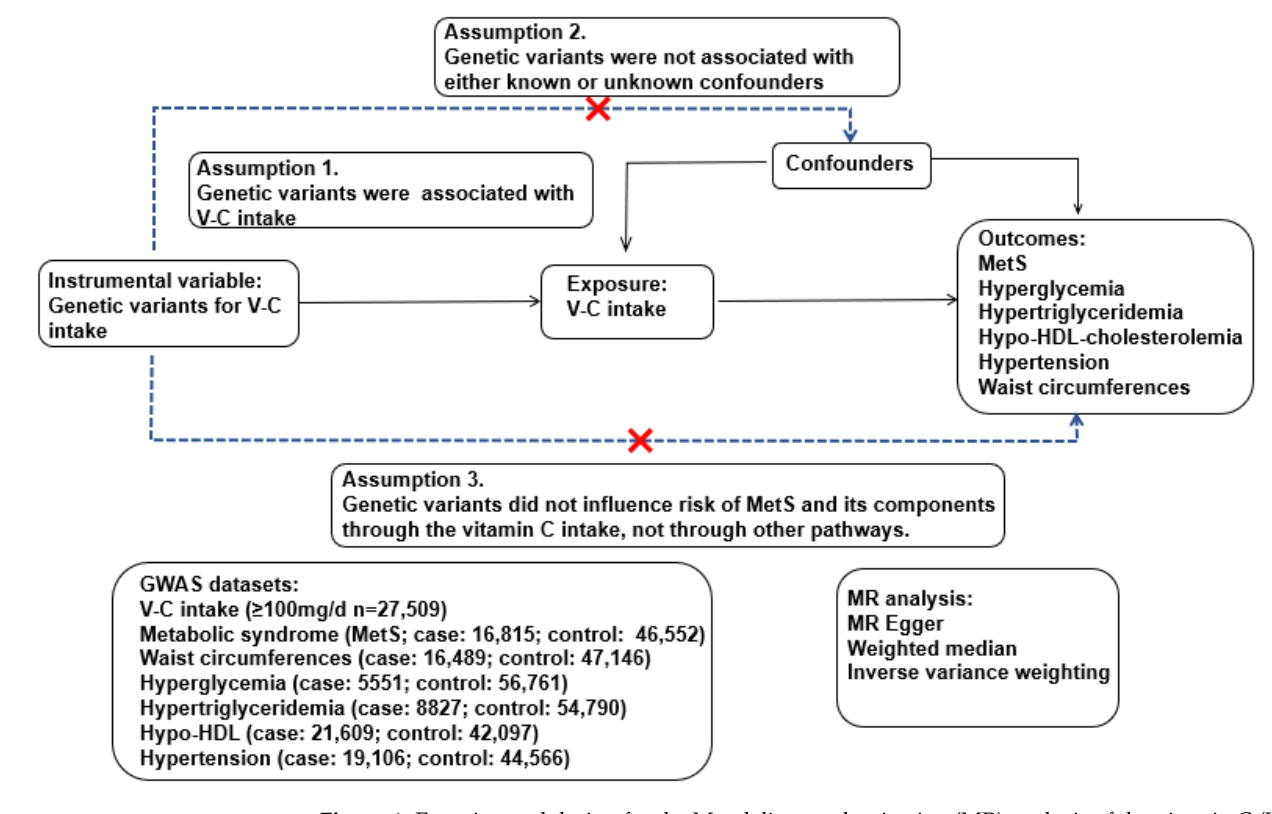
Figure 1. Experimental design for the Mendelian randomization (MR) analysis of the vitamin C (VC) intake with the metabolic syndrome risk.